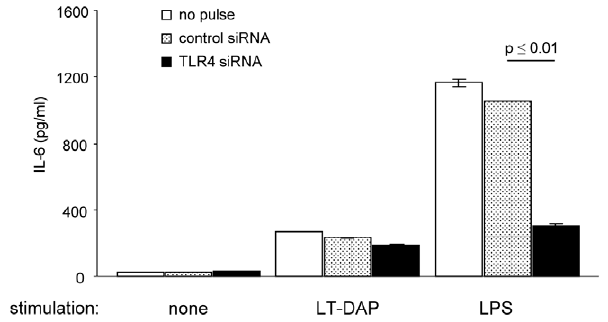
Figure 6. Functionality of siRNA in transfected cells. Primary preadipocytes were transfected with 100 pmol TLR4-specific siRNA or non-coding control siRNA using the combined HV/LV pulse strategy (3 kV/cm, 400 m s; 1.5 kV/cm, 5 ms). One day after transfection, cultures received 1 m g/ml LPS or 200 nM LT-DAP for additional 24 h before IL-6 production was determined from the cell culture supernatants. Bars represent the mean of n=3 6 SEM.